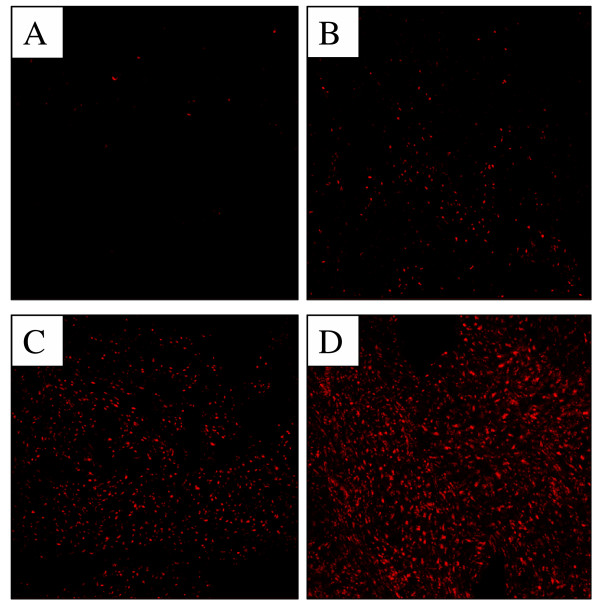
Representative images for necrosis (propidium iodide) in the following protocols: aerobic control (A); 30, 90 and 180 minutes of simulated ischaemia followed by 120 minutes of reoxygenation (B, C and D respectively).